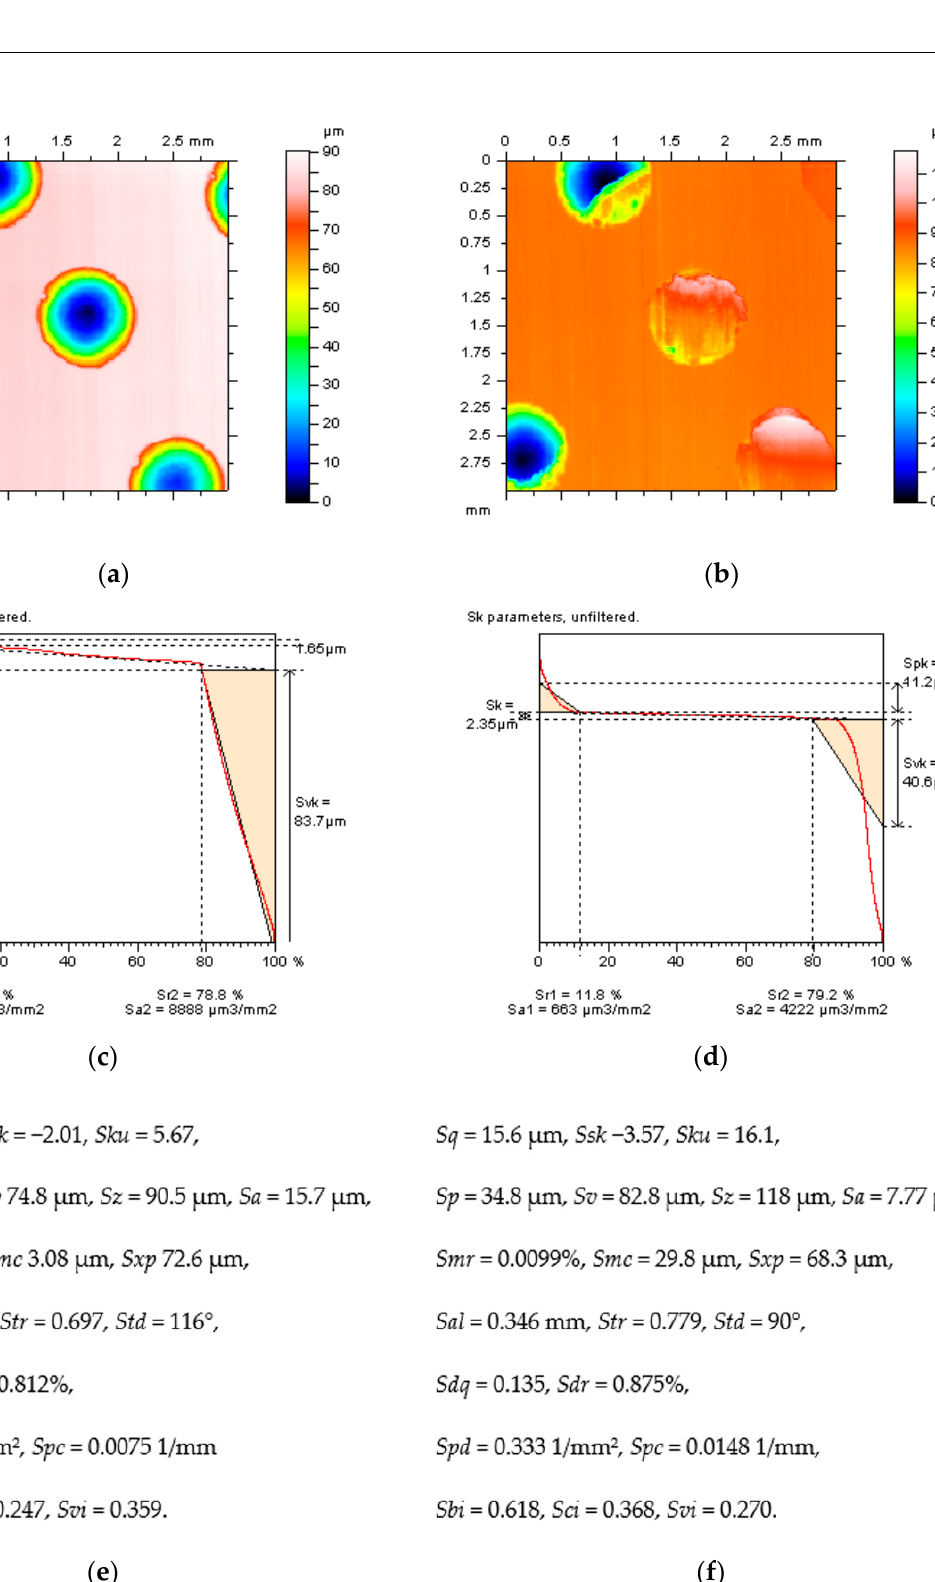
( d ) Figure 1. Areas with selected parameters, correspondingly, and profiles of measured by the stylus ( a , b ) or optical ( c , d ) instruments surface topographies of zero-wear ( a , c ) and running-in ( b , d ) plateau-honed cylinder liner textures. 2.2. Analysed Details and Parameters In this paper, the cylinder liners after the plateau-honing process and plateau-honed cylinder liners with dimples (oil pockets) created additionally by the burnishing tech- niques, were considered. The dimple size, depth and width (diameter) were between 0.08 and 0.12 mm and between 0.5 and 1 mm correspondingly. In Figure 2 examples of isomet- ric views (a,b), material ratio curves (c,d) and selected parameters (e,f) from the plateau- honed cylinder liners with additionally burnished dimples with depth and width equal to 0.08 mm and 0.8 mm respectively were presented. The values of the following surface topography parameters (from ISO 25178-2 stand- ard) were measured and studied: arithmetic mean height Sa, auto-correlation length Sal, surface bearing index Sbi, core fluid retention index Sci, mean dale area Sda, root mean square gradient Sdq, developed interfacial areal ratio Sdr, mean dale volume Sdv, core roughness depth Sk, kurtosis Sku, inverse areal material ratio Smc, areal material ratio